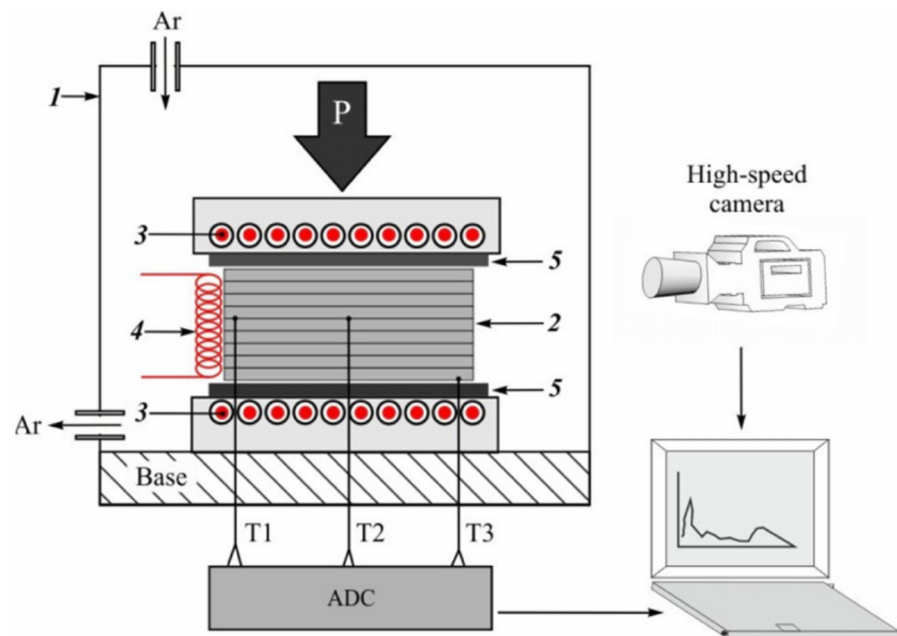
Figure 1. Schematic of the experimental setup: (1) reactor, (2) sandwich-like sample, (3) heaters, (4) igniting coil, and (5) graphite plates; T1, T2, T3 thermocouples